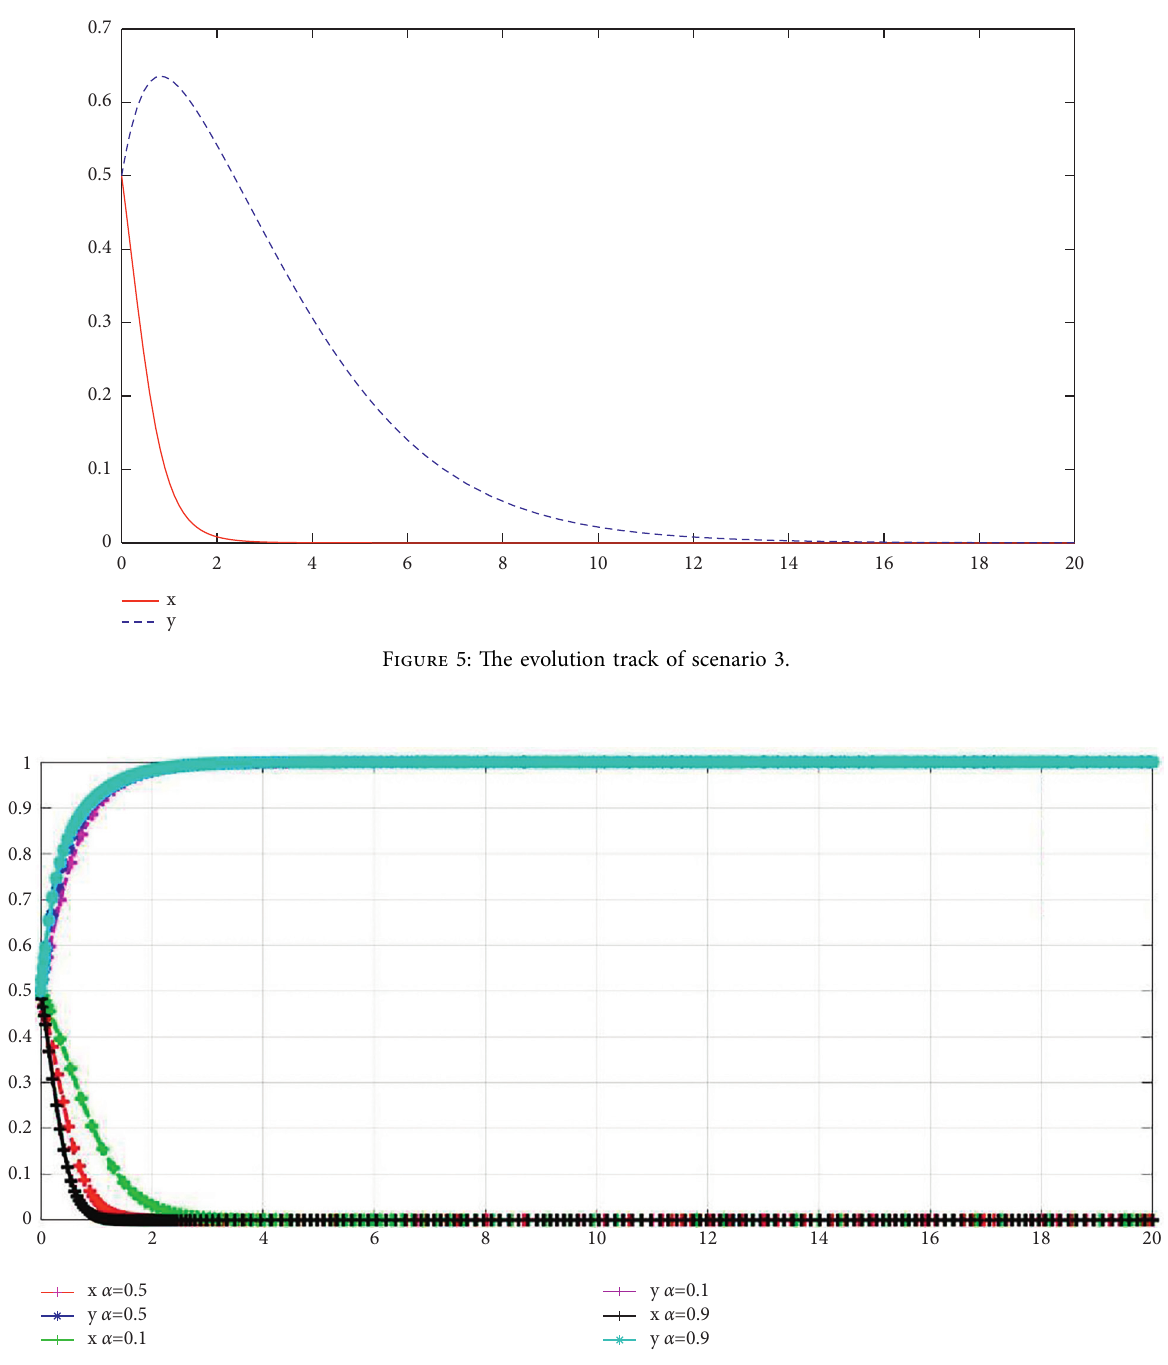
Figure 6: Evolution track of different supply-oriented policy intensities.